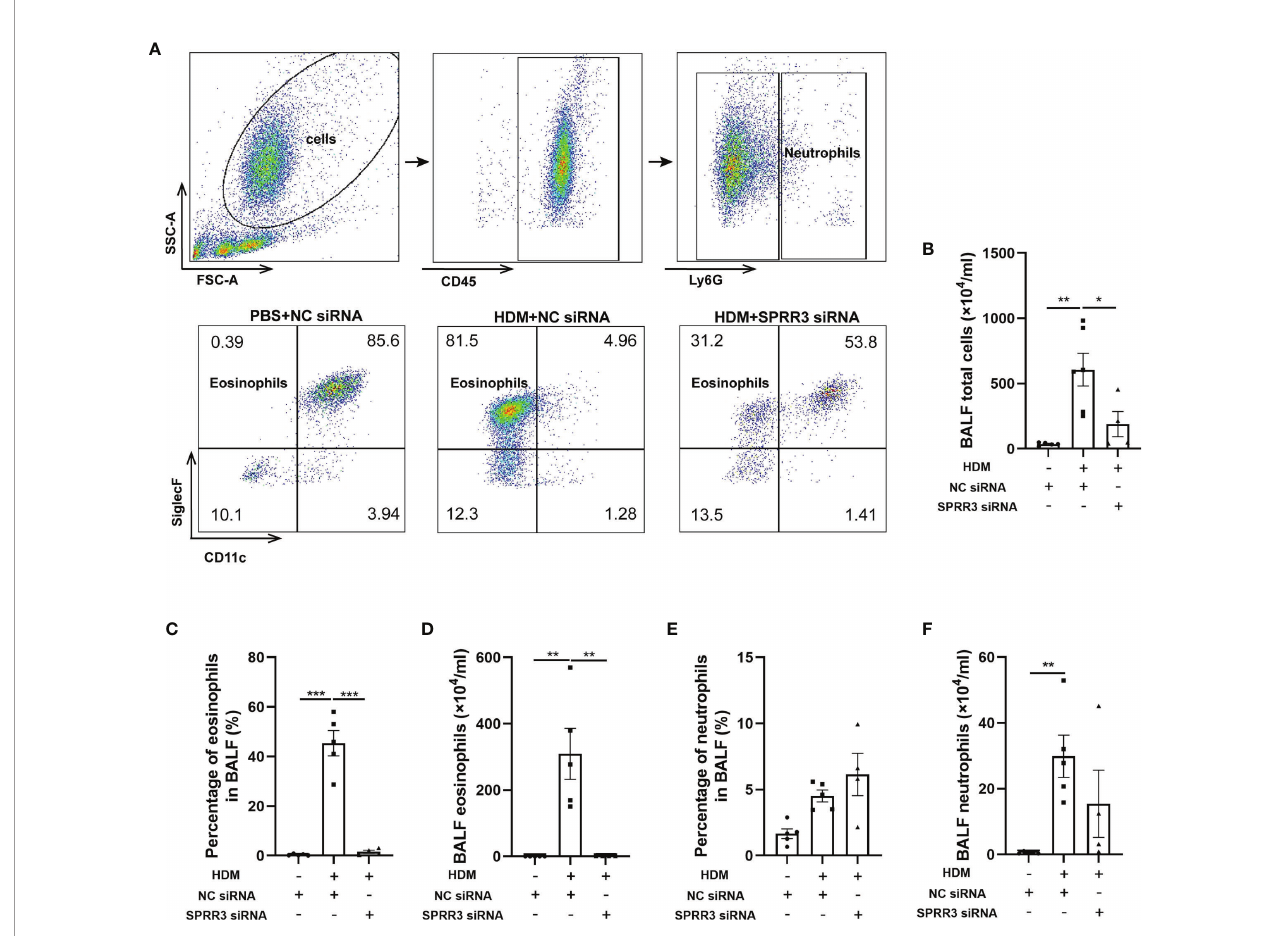
FIGURE 3 | SPRR3 knockdown decreases the number of in fl ammatory cells in bronchoalveolar lavage fl uid (BALF). Flow cytometry was used to analyze the in fl ammatory cells in BALF. Among BALF cells, neutrophils were gated as CD45 + Ly6G + , and eosinophils were gated as CD45 + Ly6G − CD11c − SiglecF + . (A) Flow cytometric dot plots of CD11c − SiglecF + eosinophils gated on CD45 + Ly6G − cells. (B) The counts of BALF total cells. (C) The percentage of eosinophils in BALF. (D) BALF eosinophil counts. (E) The percentage of neutrophils in BALF. (F) BALF neutrophil counts. Values represent mean ± SEM, n = 4 – 6 for each group. * p < 0.05, ** p < 0.01, *** p <